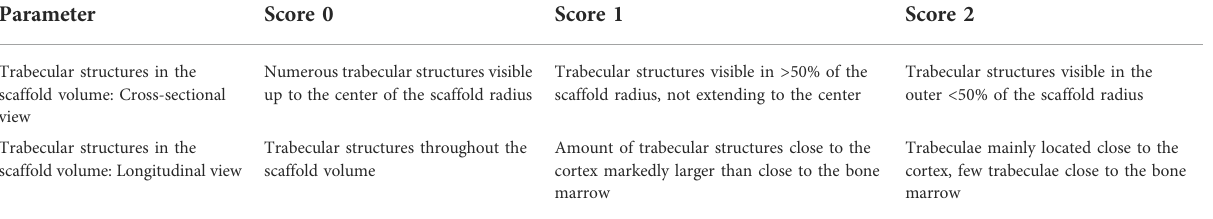
TABLE 3 Scoring system for the semi-quantitative evaluation of the µCT 80